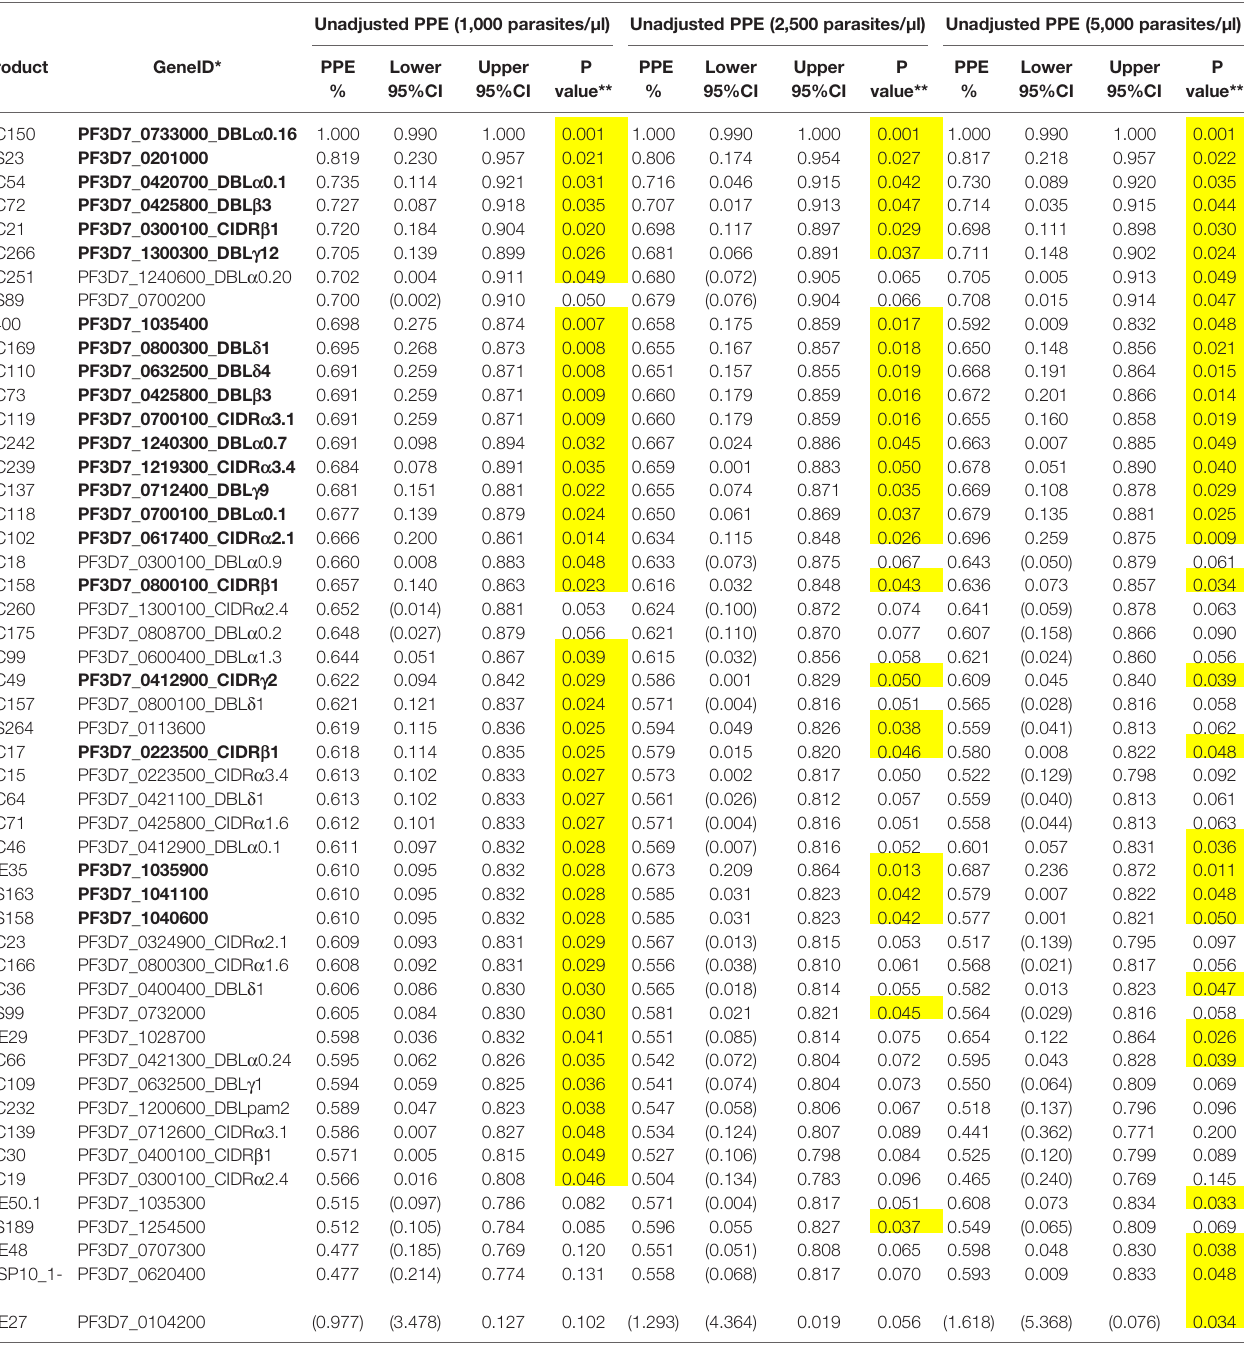
*In bold are the proteins cross-selected by the three malaria de fi nations. **Yellow highlighted P values: statistically signi fi cant by the unadjusted